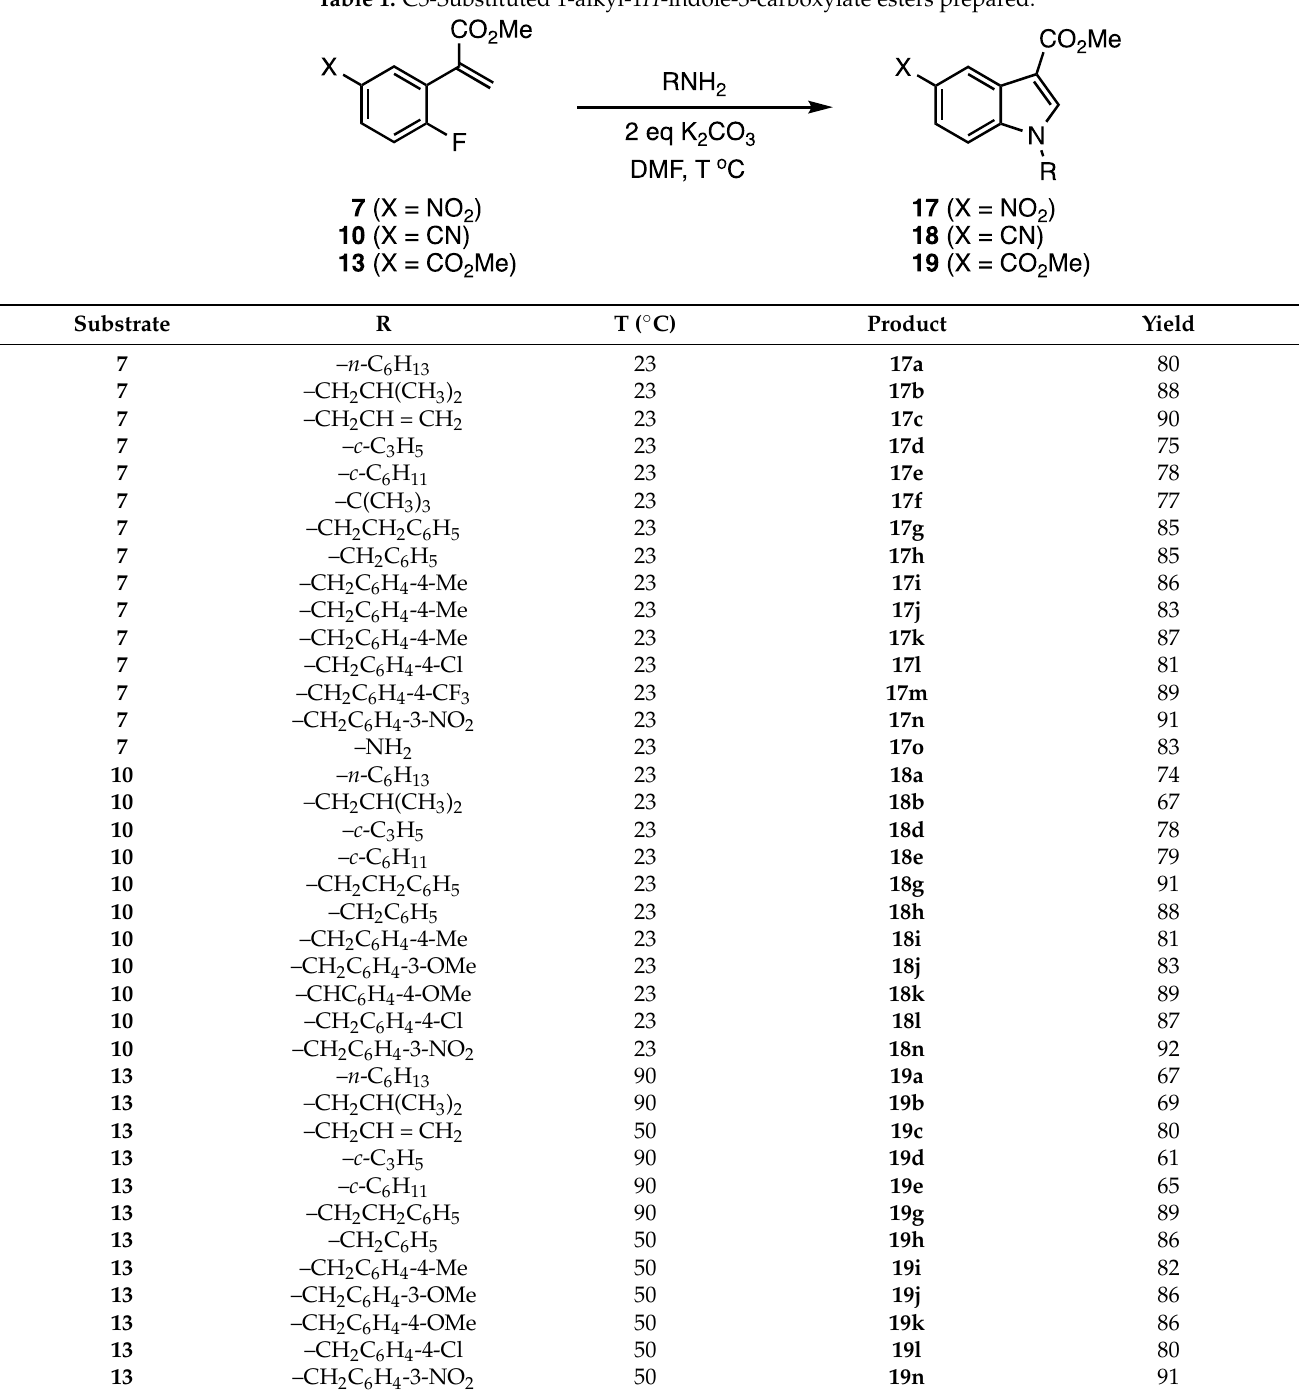
Table 1. C5-Substituted 1-alkyl-1 H -indole-3-carboxylate esters prepared.